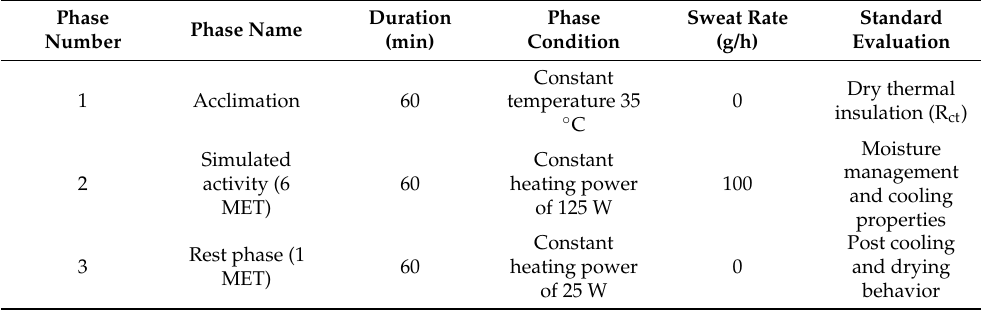
Table 3. Standard test profile representing the three consecutive phases and the requirements to assess thermophysiological properties of fabrics